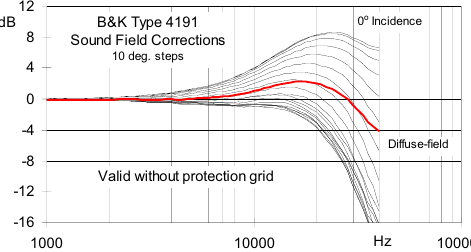
Fig. 8. Free-field corrections of WS2 microphone measured in steps of 10 ◦ sound incidence and the diffuse-field correction calculated in accordance with IEC61183.